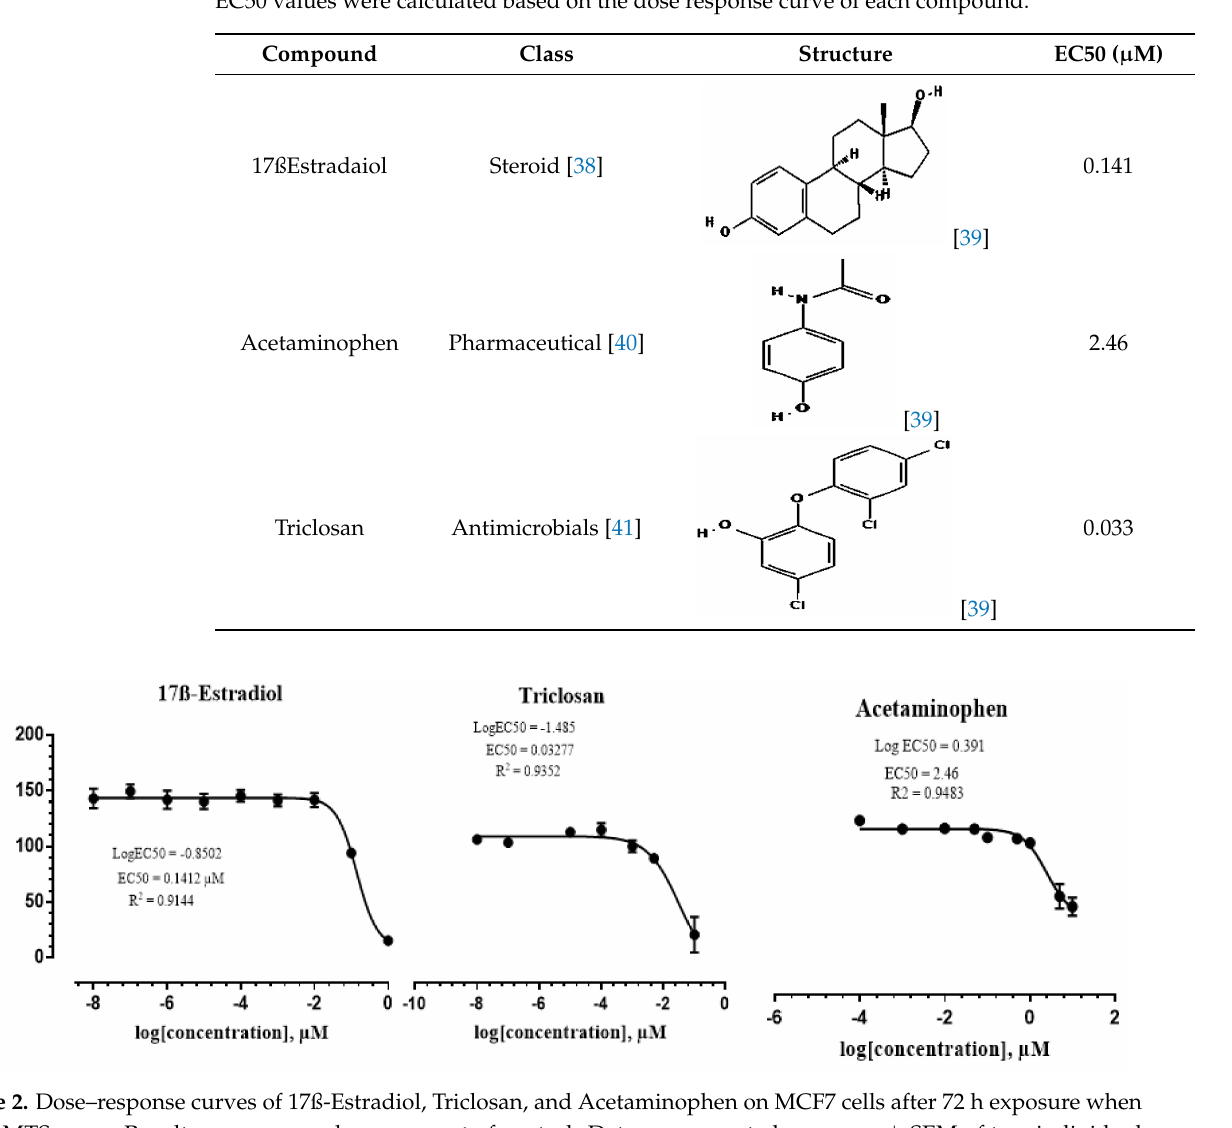
Table 3. Estrogenic response of MCF7 cells to 17ß-Estradiol, Acetaminophen, and Triclosan. The EC50 values were calculated based on the dose response curve of each compound.